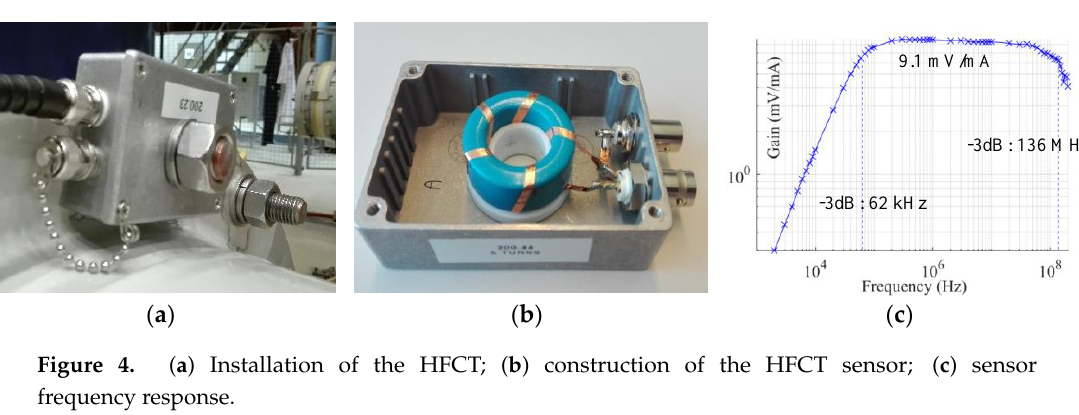
Figure 4. ( a ) Installation of the HFCT; ( b ) construction of the HFCT sensor; ( c ) sensor frequency response.